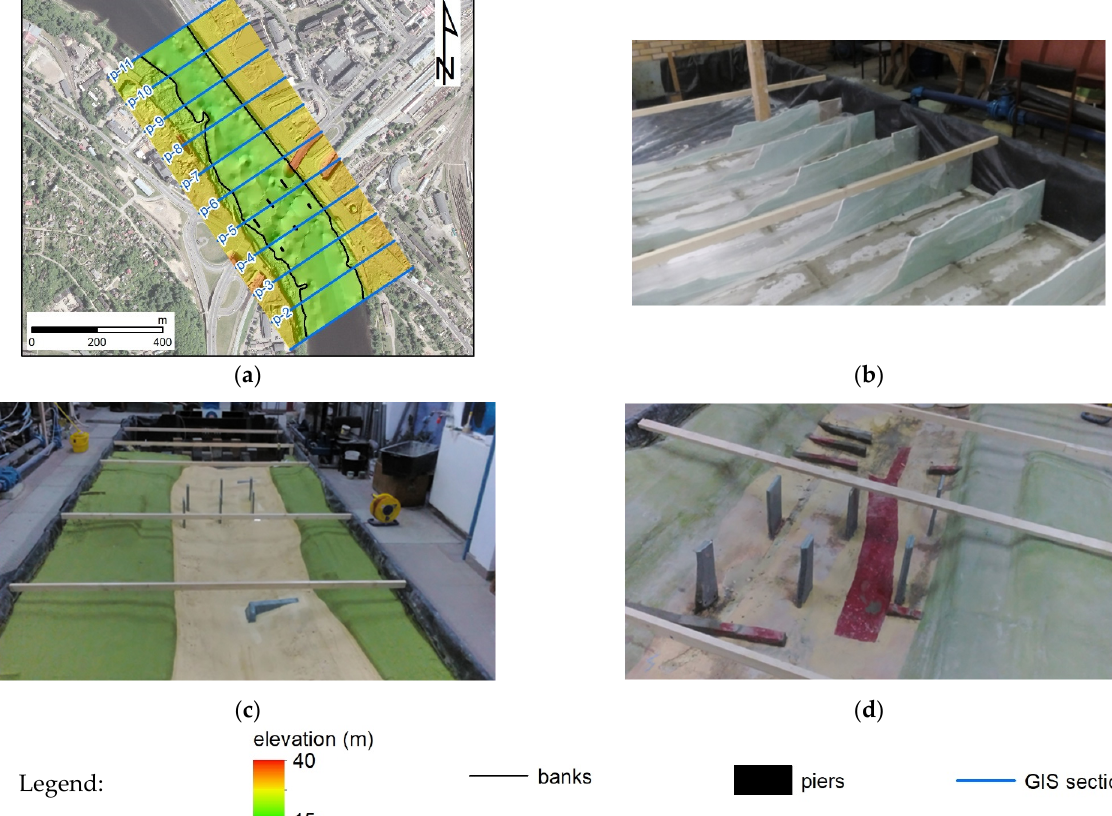
Figure 5. Physical model preparation: ( a ) DTM with interpolated bathymetry, ( b ) the cross-sections, ( c ) the final version, ( d ) piers, spur dikes, and waterway.